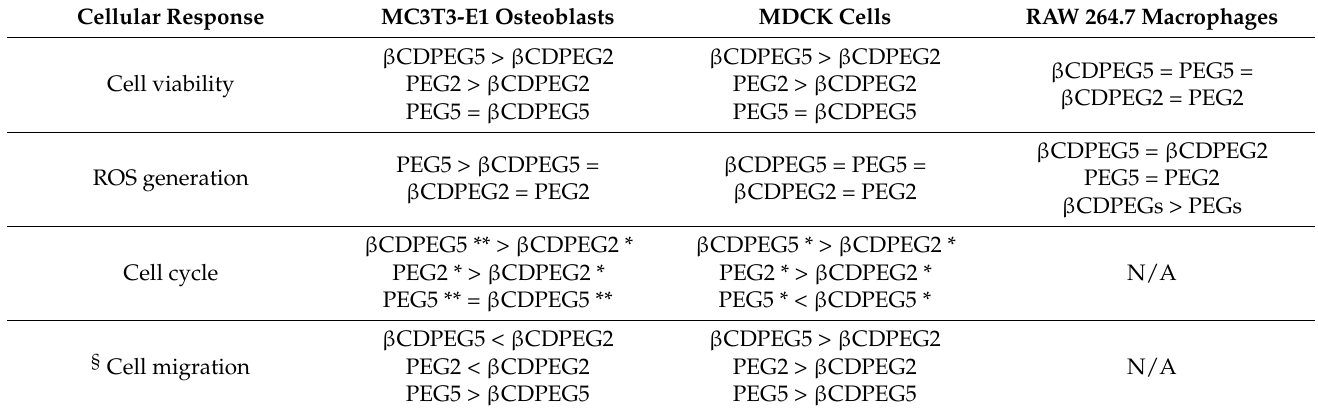
Table 1. Global effects of β CDPEGs and PEGs on MC3T3-E1 and MDCK cells. Cellular Response MC3T3-E1 Osteoblasts MDCK Cells RAW 264.7